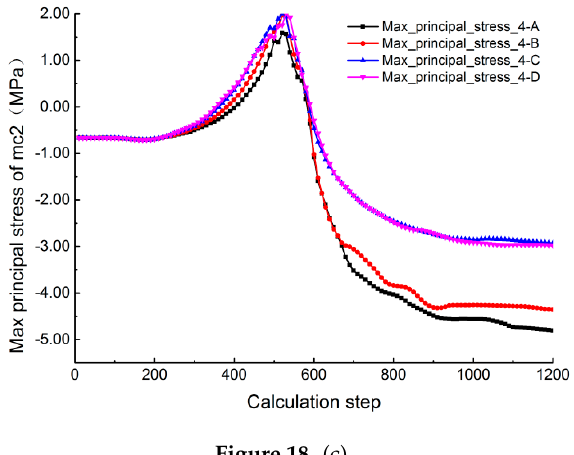
Figure 15. Fluid pressure zones for different interaction modes.